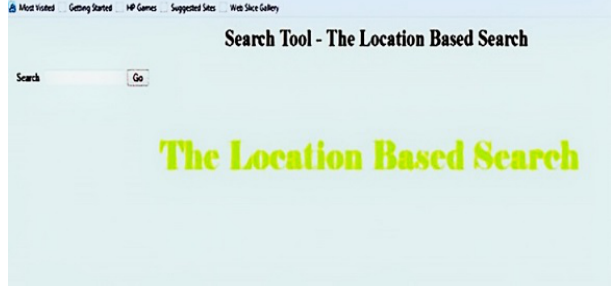
Table 7. Comparison of Geo/Geo search results